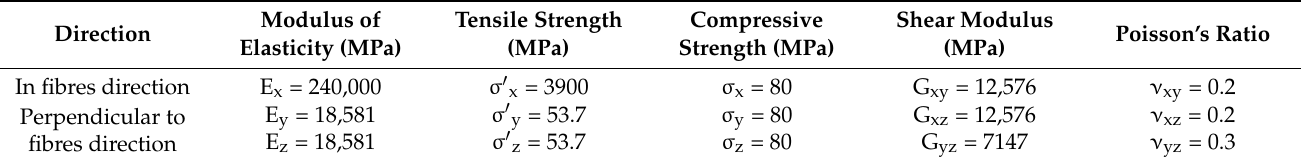
Table 2. Mechanical properties of CFRP sheets used for modelling [3].